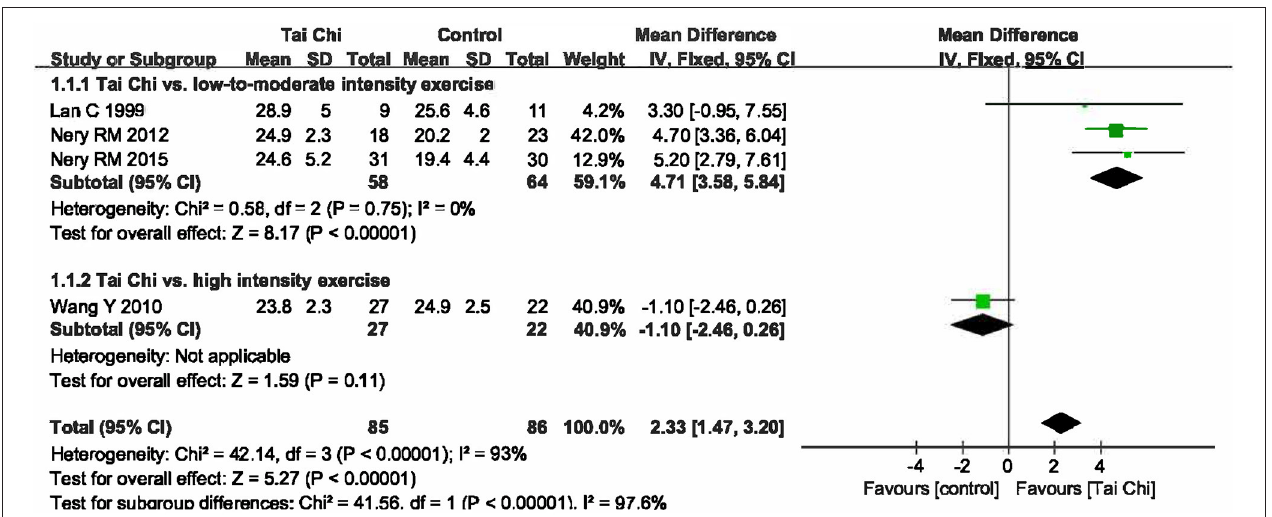
FIGURE 3 | Forest plot of the comparison between Tai Chi and positive control for the outcome VO 2 max.